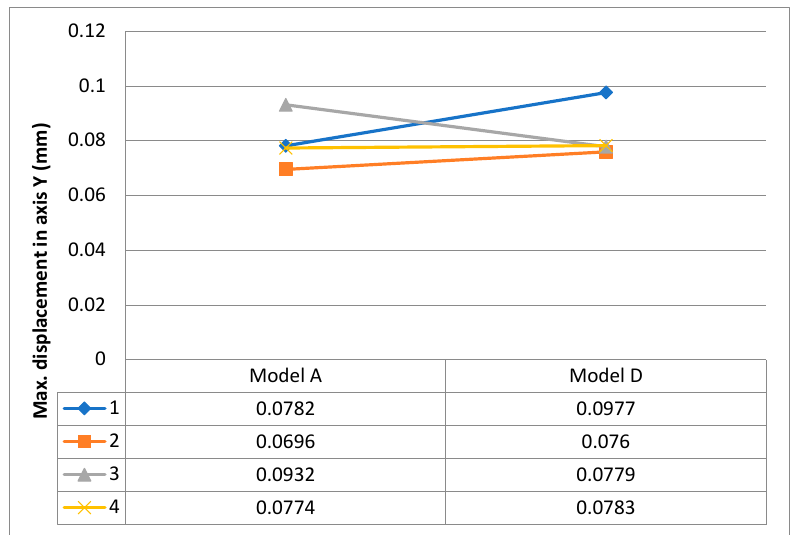
Energies 2022 , 15 , x FOR PEER REVIEW Figure 15. Compared maximum displacement values in the Y -axis in the analyzed models. The displacement of the lip towards the gears (axis Y ) was also observed in the ex- perimental pump. Figure 16 shows wear of the casing both on the suction side 3 and on the discharge side 1 in the integrated lip type A. Traces of the interaction are more visible on the suction side, as the gears are pushed more towards the low-pressure side. The measured thickness of the layer selected during the running-in of the pump was not greater than 0.1 mm, and this fact confirms that both the investigated discrete model and the applied boundary conditions (loads and restraints) are proper. During visual inspec- tion, the wells also revealed a limited-area matt surface 2 which indicates that the gears did not interact in this region.